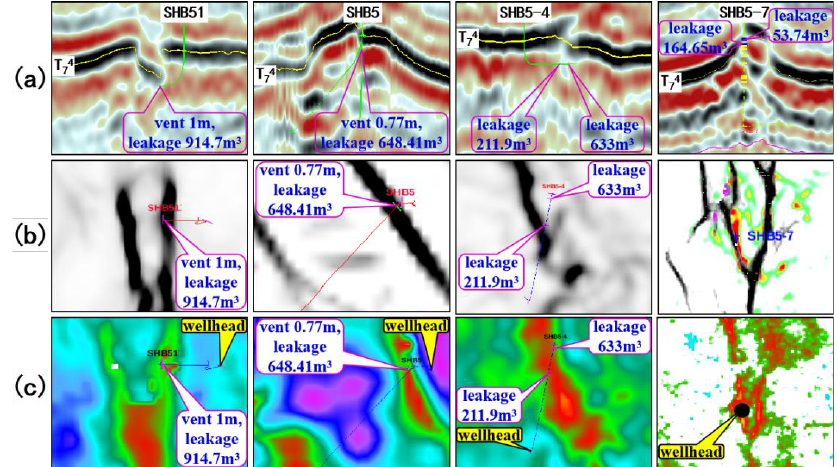
Figure 4. A fault profile and plane characteristics of Yijianfang Formation marker wave group. ( a ) seismic profile. The pink box indicates the location and data of drilling venting and leakage; ( b ) weak coherence stratum slice along T 74 seismic horizon. The color represents the coherence value. The darker the color is, the weaker it is. It can predict the plane position of fault; ( c ) weak amplitude stratum slice along T 74 seismic horizon. The color represents the amplitude attribute value. The redder, the weaker, and the plane position of the fault is predicted.